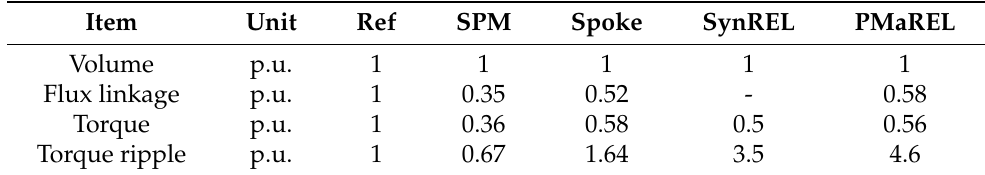
Table 4. Performance comparison among the five motors.